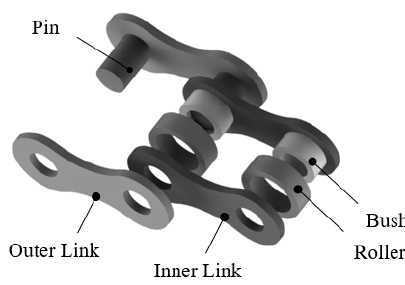
Figure 1. Schematic of roller chain and its components.